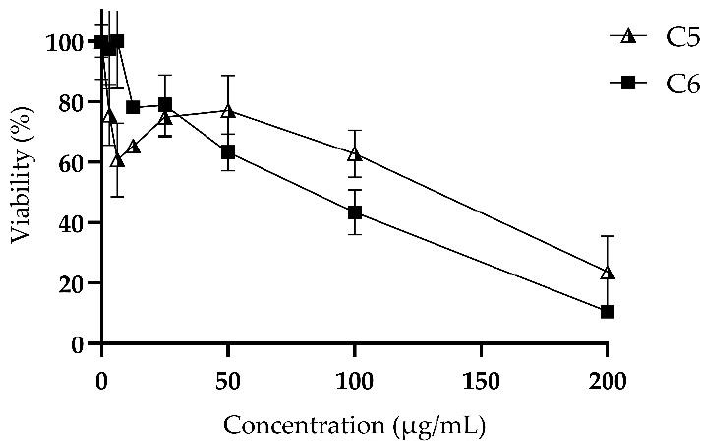
Figure 3. Cytotoxic effect of peptides on the mouse fibroblast cell line L929. Chimera C5: RRWQWR- Ahx-KLLKKLLK (black and white triangle shape) and chimera C6: KKWQWK-Ahx-RLLRRLLR (black box shape).